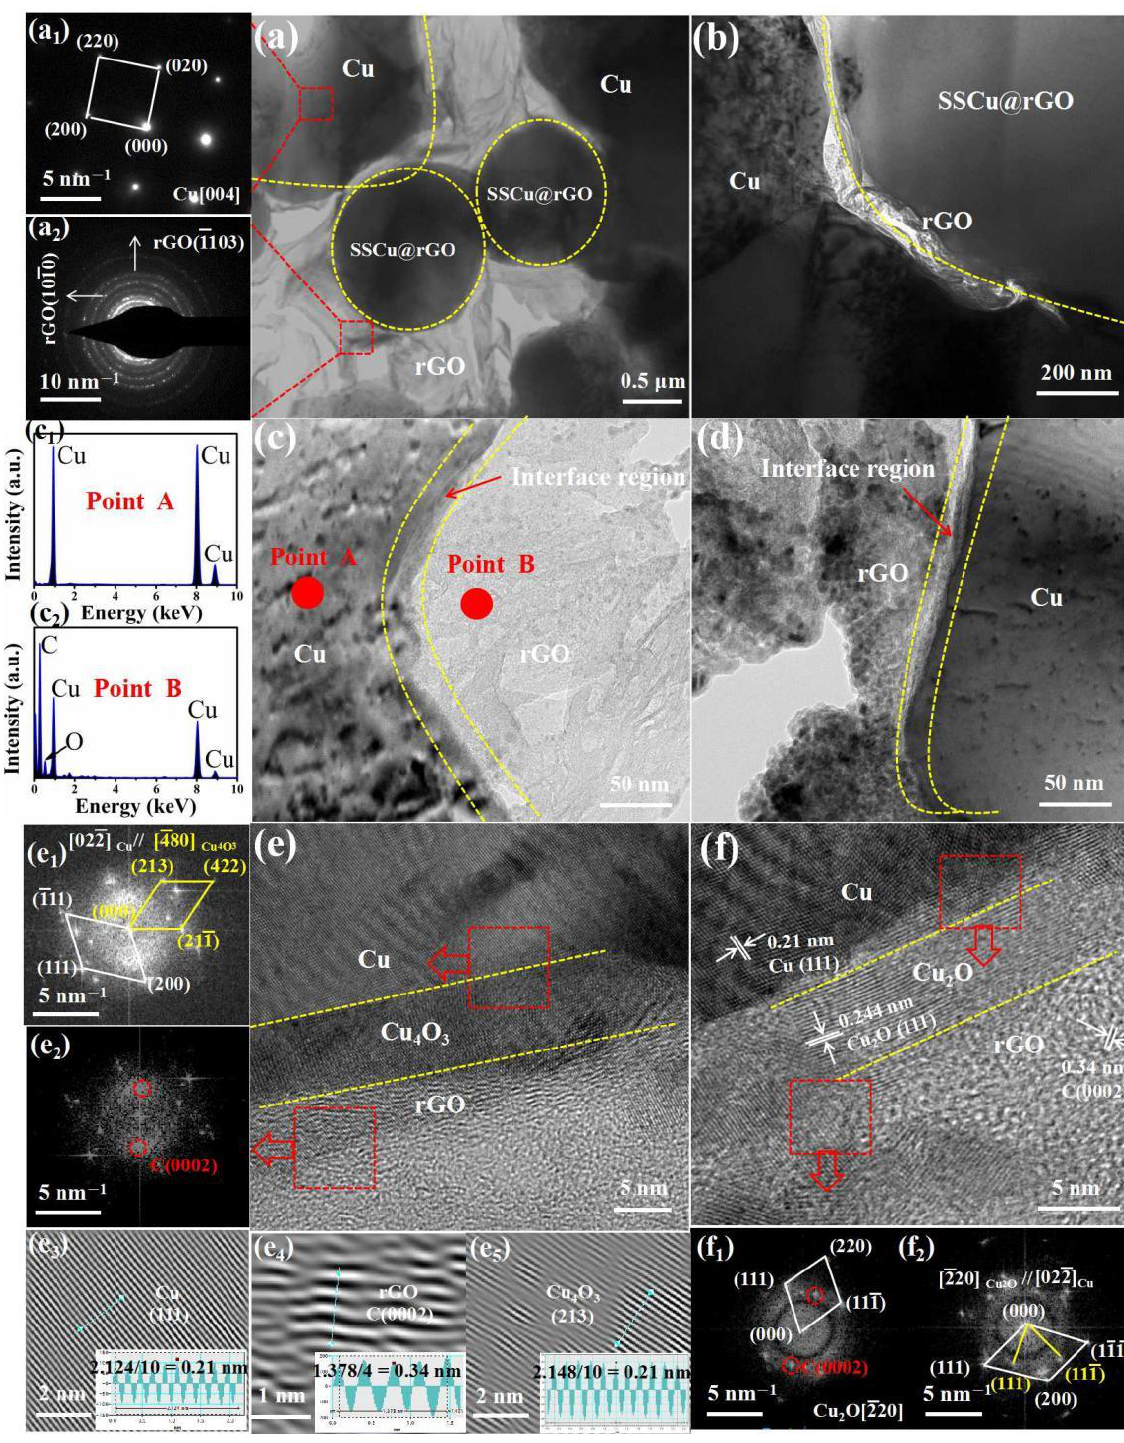
Figure 4. TEM images of the SSCu@rGO/Cu composites: ( a , a 1, a 2, b ) morphology of SSCu@rGO. ( c , c 1, c 2, d ) Interface structure diagram of Cu and rGO. ( e , e 1 – e 5) Interface analysis of Cu/Cu 4 O 3 /rGO. ( f , f 1, f 2) Interface analysis of Cu/Cu 2 O/rGO.